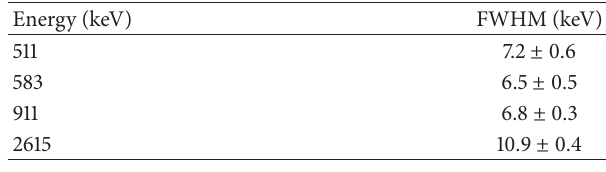
Table 1: Energy resolutions of gamma-ray full absorption peaks in the calibration measurement.